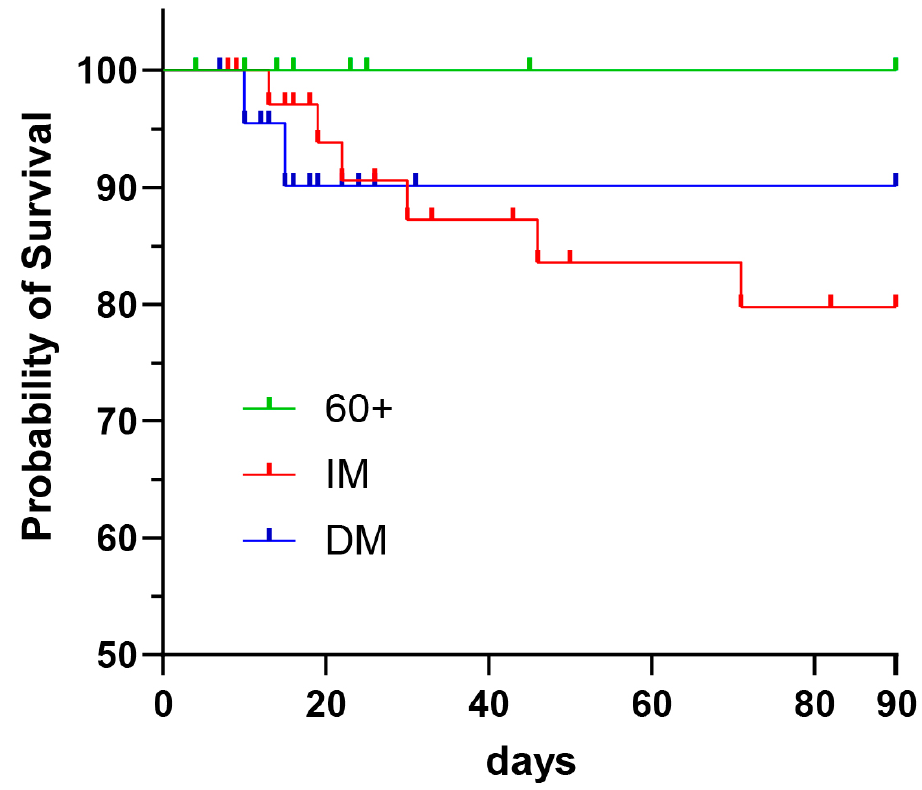
Figure 9. Kaplan–Meier estimate showing the probability of survival for elderly (60+), immunocom- promised (IM) and diabetes mellitus (DM) patients. Patients’ survival was monitored for 90 days after the first positive SARS-CoV-2 PCR.